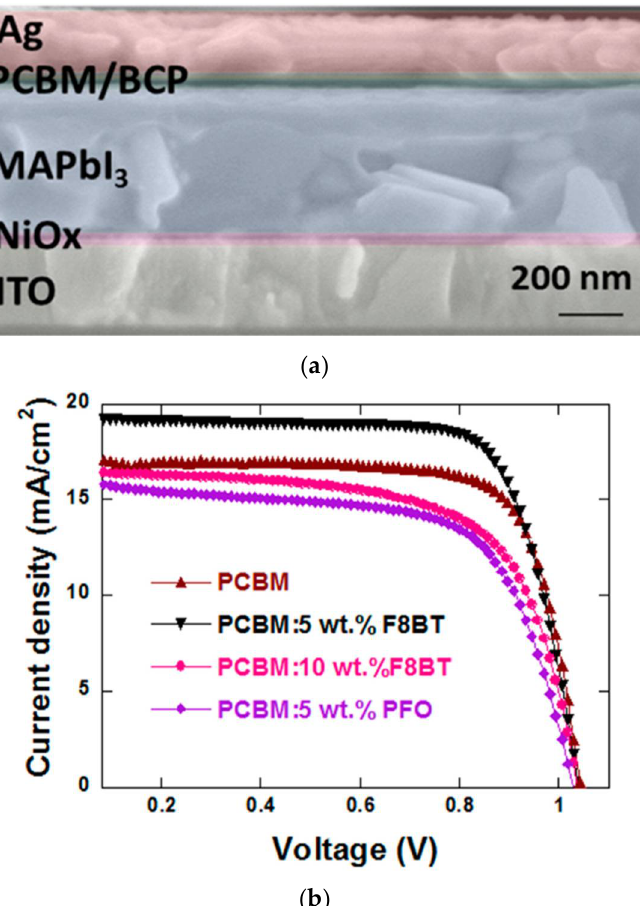
Figure 6. The sectional SEM image of PSC ( a ) and photocurrent density–voltage curves of the devices with F8BT in PCBM ( b ) [174].